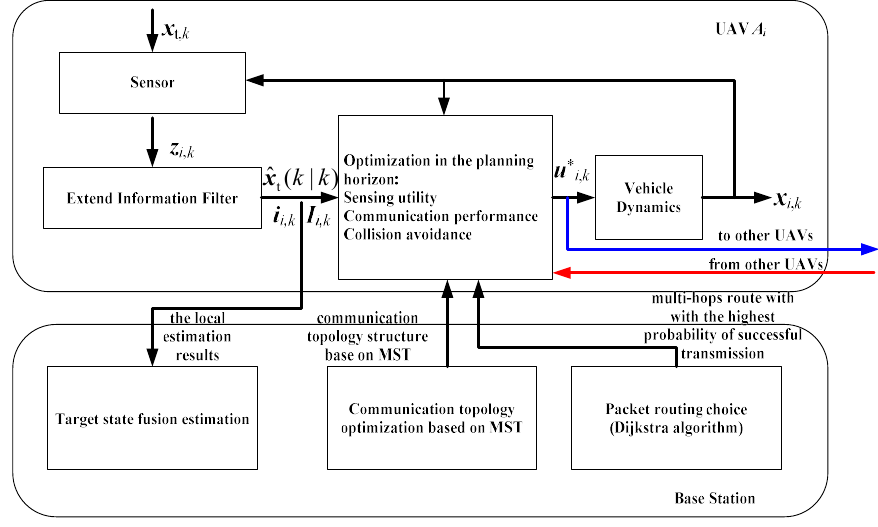
Figure 5. Processing diagram for multi-UAVs cooperative target tracking algorithm.